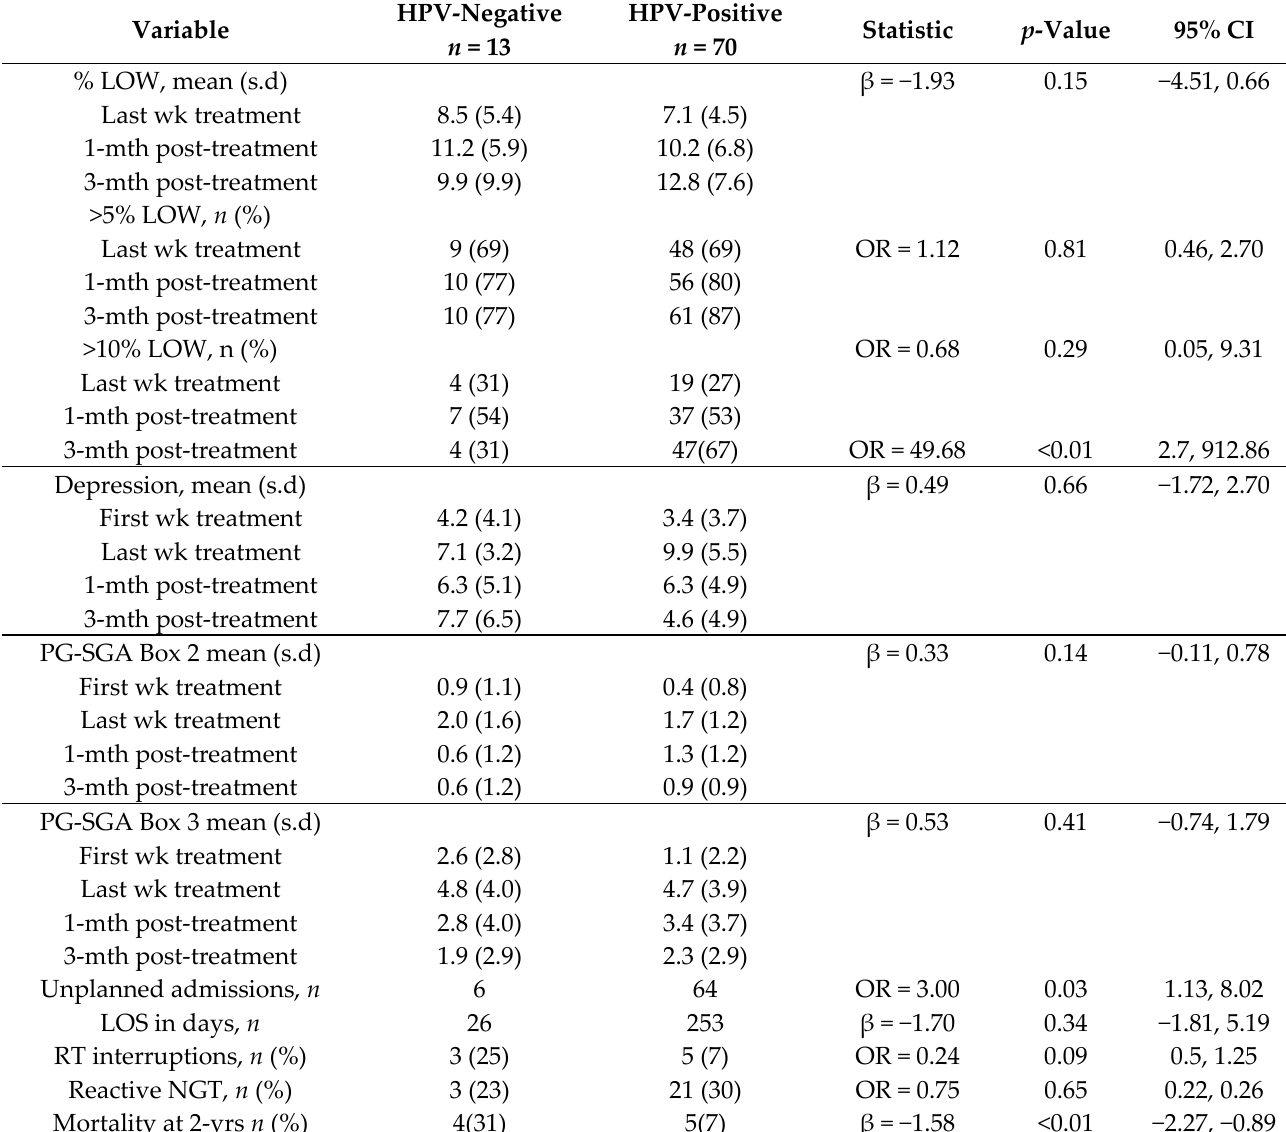
Table 3. Secondary outcomes: HPV-positive and HPV-negative in a linear mixed model of mean LOW, depression, PG-SGA Box 2 and 3 across end of treatment, 1 months and 3 months post treatment.